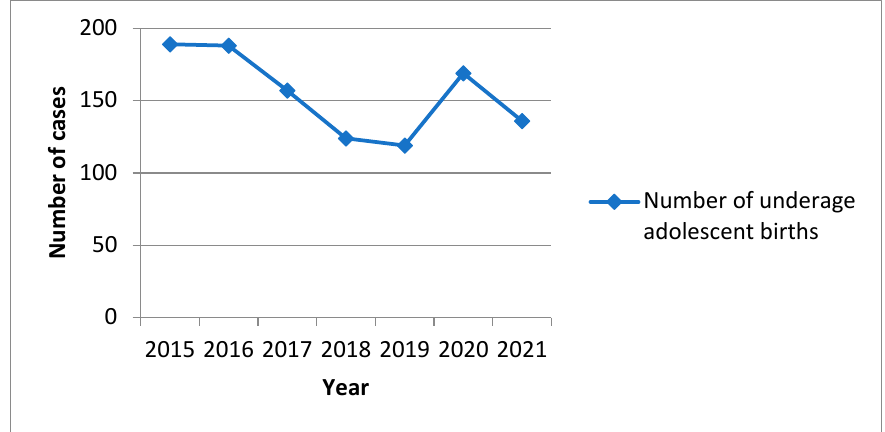
Figure 1. Trend in the number of underage adolescent pregnancy per year. Table 1. Characteristics of pregnant teenagers in our study population (part I).